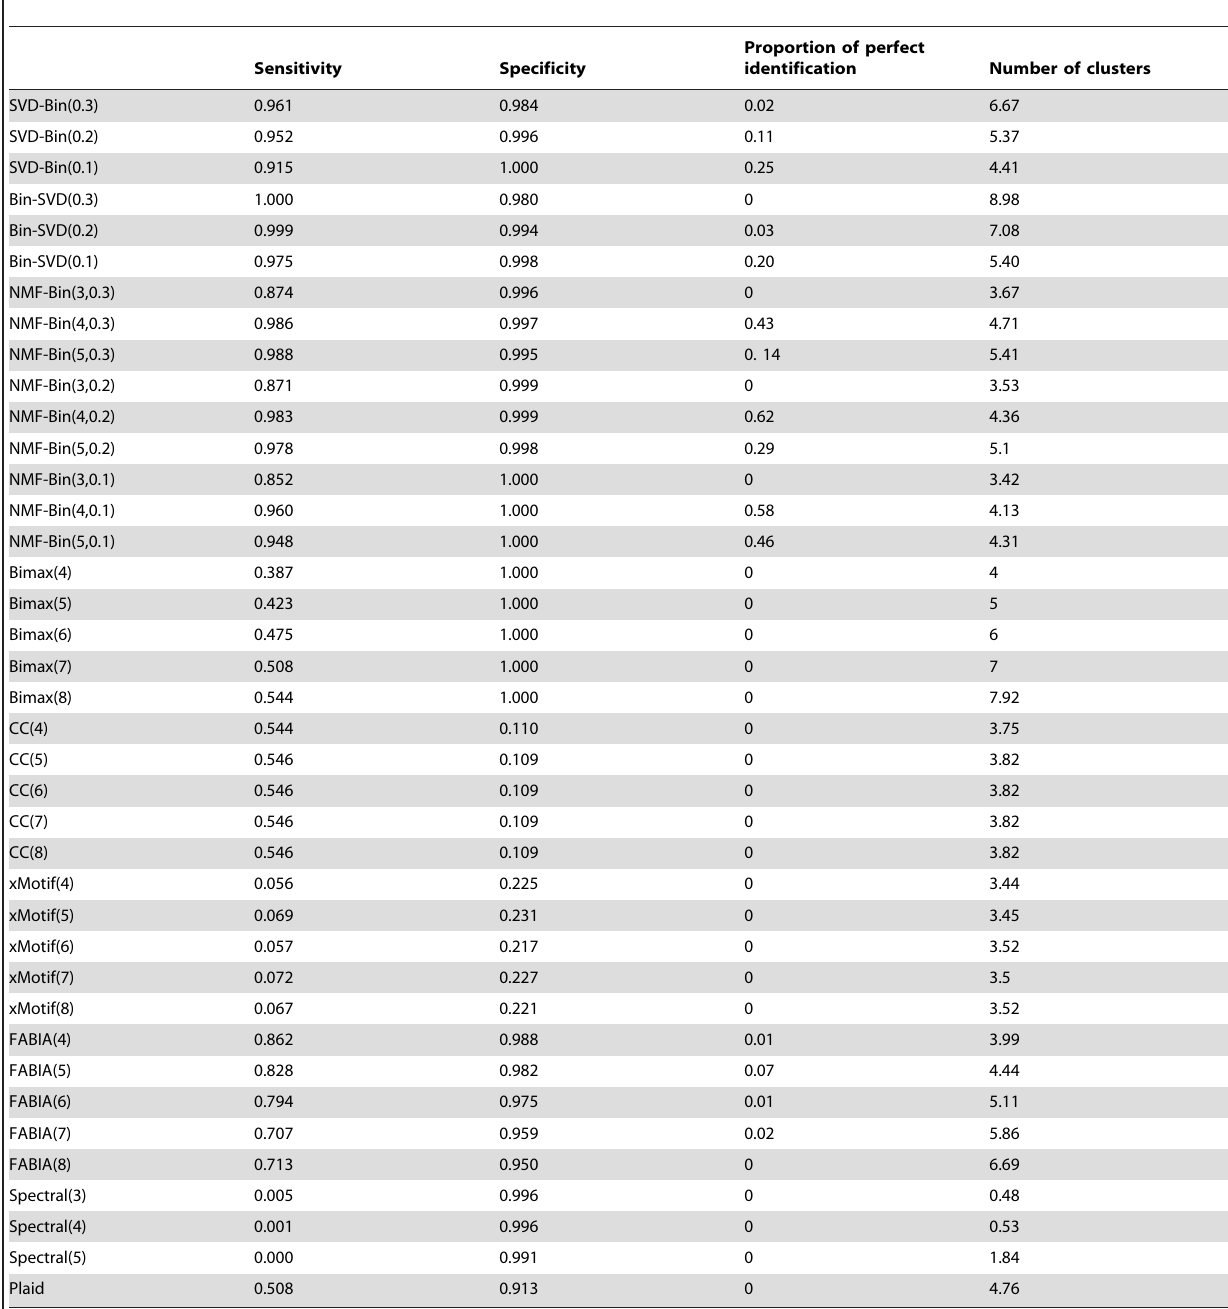
Table 1. Performance of SVD-Bin( d ), Bin-SVD( d ), NMF-Bin( f , d ), Bimax( k ), CC( k ), xMotif( k ), Spectral( f ), and FABIA( k ) on a quantitative synthetic dataset where d is the tolerance threshold, f is the number of factorization ranks, and k is the number of